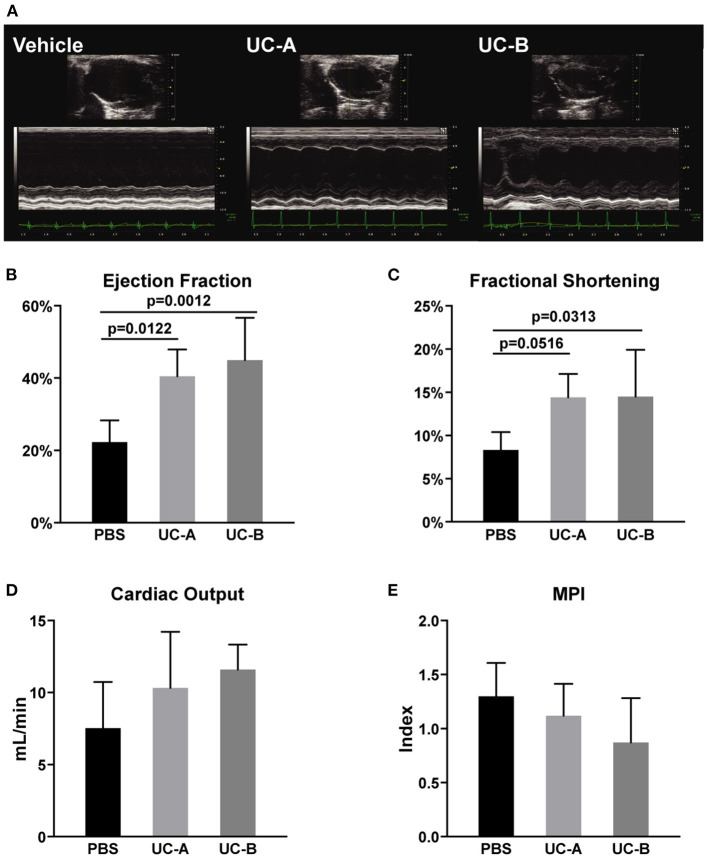
Long term improvement in left ventricle systolic function 12 weeks after MI and UCM-MSC delivery from the 2 donors. (A) Representative PSLAX views in B- and M-mode. (B) Ejection fraction and (C) fractional shortening calculated using the Simpson's method (PSLAX B-mode). (D) Cardiac output determined through the quantification of the left ventricular outflow tract stroke volume (LVOT SV) in PW-doppler mode, aortic root diameter and Heart rate. (E) Myocardial Performance Index was assessed computing exclusively PW-doppler data (Mitral Valve Closure to Opening Time (MVCOT) and LV Ejection time). Mean ± SD.